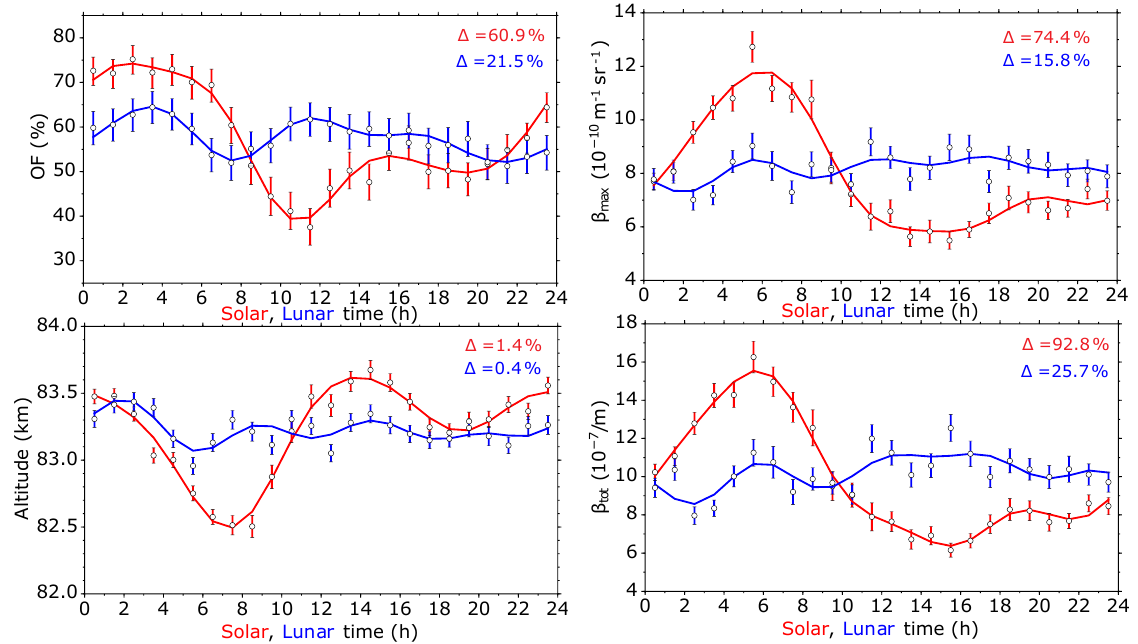
Figure 2. Mean solar (red) and lunar (blue) time variations of NLC occurrence frequency (OF), altitude and the maximum and integrated brightness ( β max , β tot ) between 19 June and 29 July from 1997 to 2017. Symbols are hourly mean values and vertical bars errors of the means. Solid lines are harmonic fits with periods of 24, 12, 8 and 6h to the mean values. The relative variations of the fits over day (cid:49) = ( max − min )/ mean are